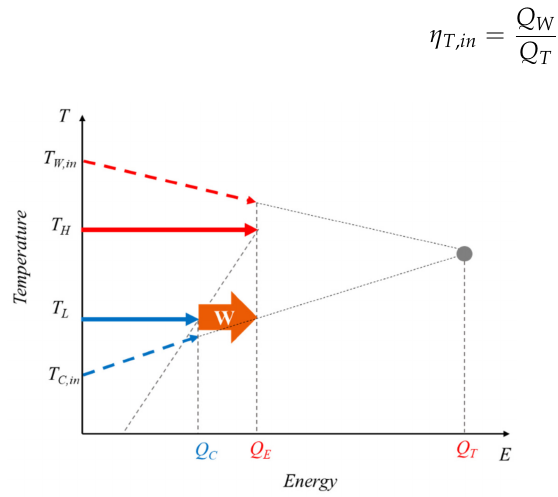
Figure 4. T – E diagram of the OTEC process using the Carnot heat engine. T H and T L are the highest and lowest temperatures in the heat engine,